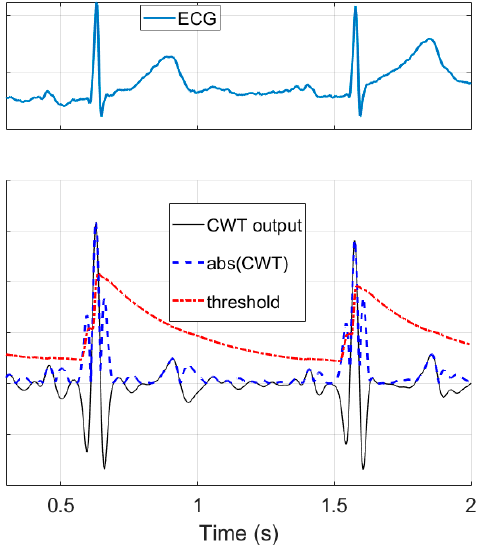
Figure 7. Example of the ECG wavelet transform with the following threshold generation: original ECG (top), wavelet transformation (CWT, bottom, black), absolute value of the CWT signal (bottom, dashed blue), and detection threshold (bottom, red).